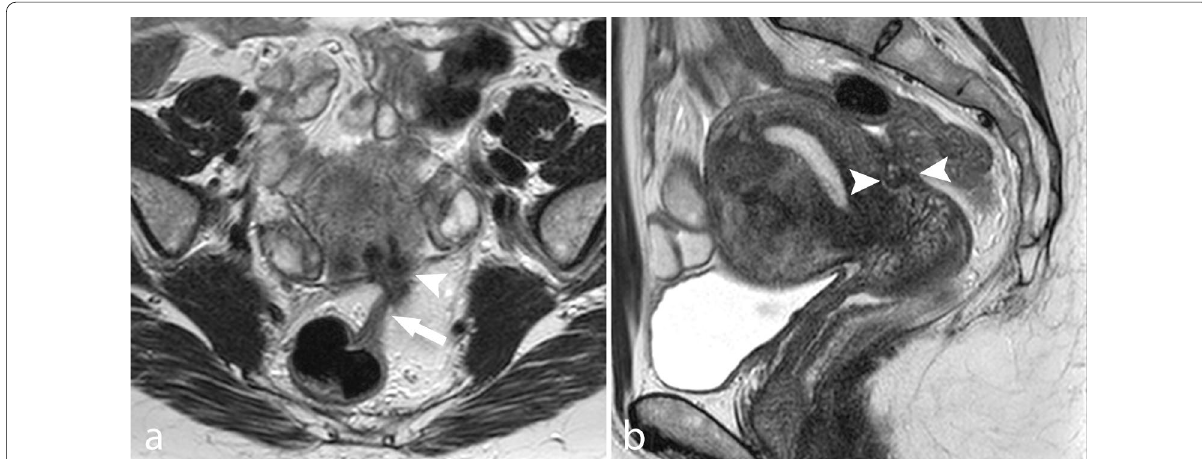
Fig. 12 Adhesive obliteration of the pouch of Douglas. TSE T2w axial ( a ) and sagittal ( b ) images. The anterior rectal wall is tethered (arrow) to the posterior surface of the uterus, where a DIE nodule is seen (arrowhead)